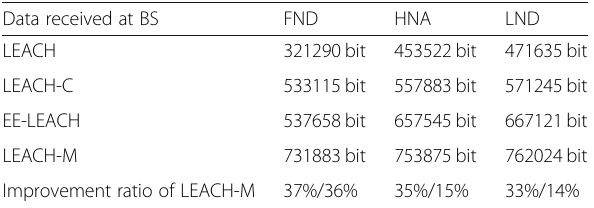
Table 5 The statistics of received data at BS of four algorithms in 100 × 100m